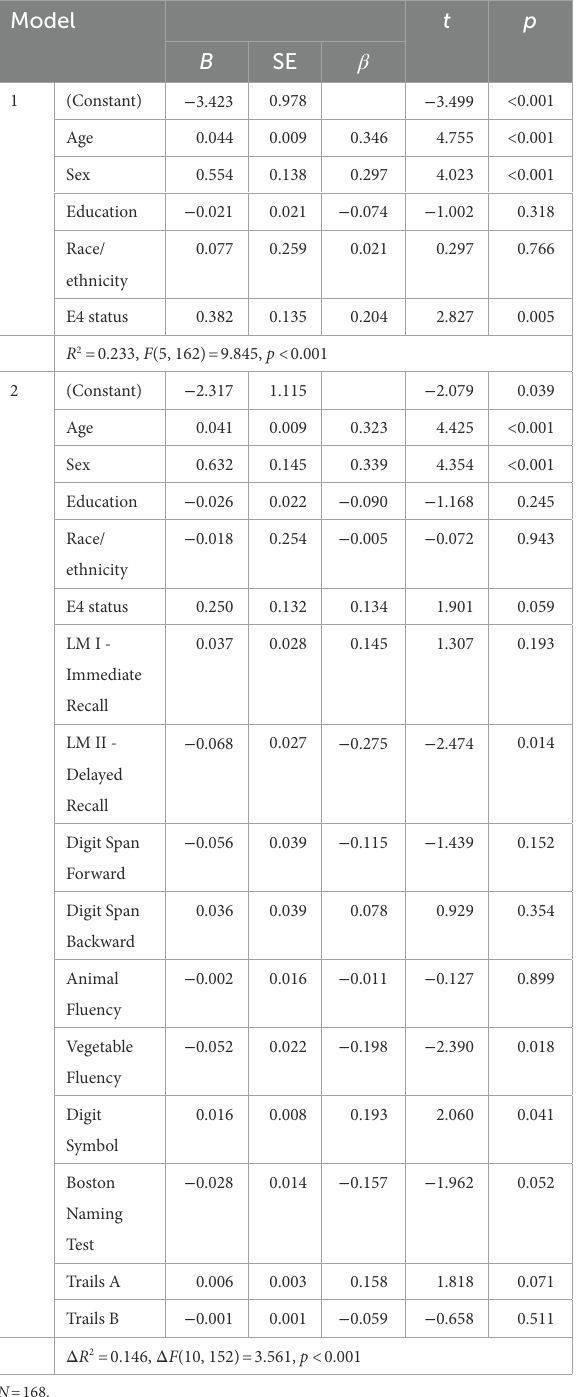
TABLE 2 Hierarchical regression model of cognitive correlates of pathological functioning in MCI group.